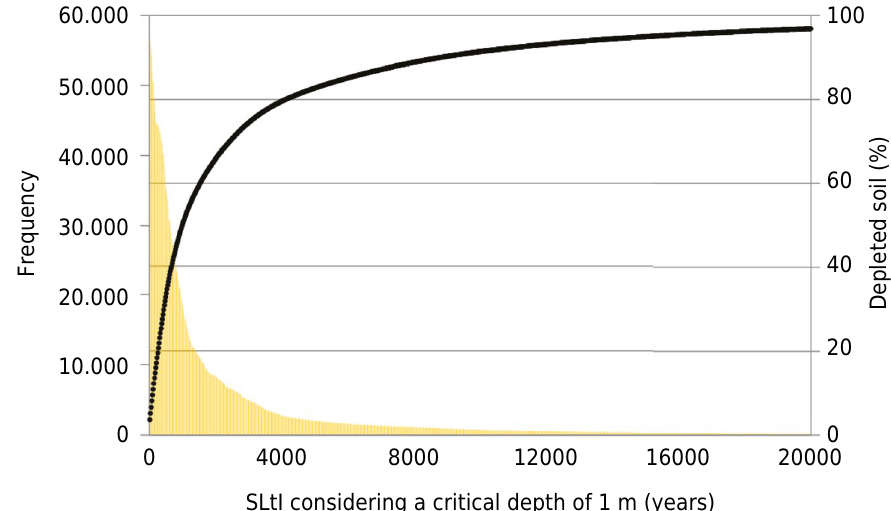
SLtI considering a critical depth of 1 m Figure 7. Histogram of the Soil Lifetime Index (SLtI) considering a critical depth of 1 m.